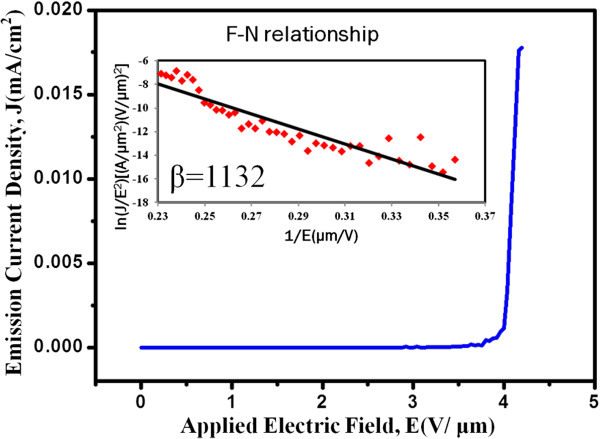
The field emission plot of δ-Ni2Si NWs. The inset shows the corresponding ln(J/E2)−1/E plot.